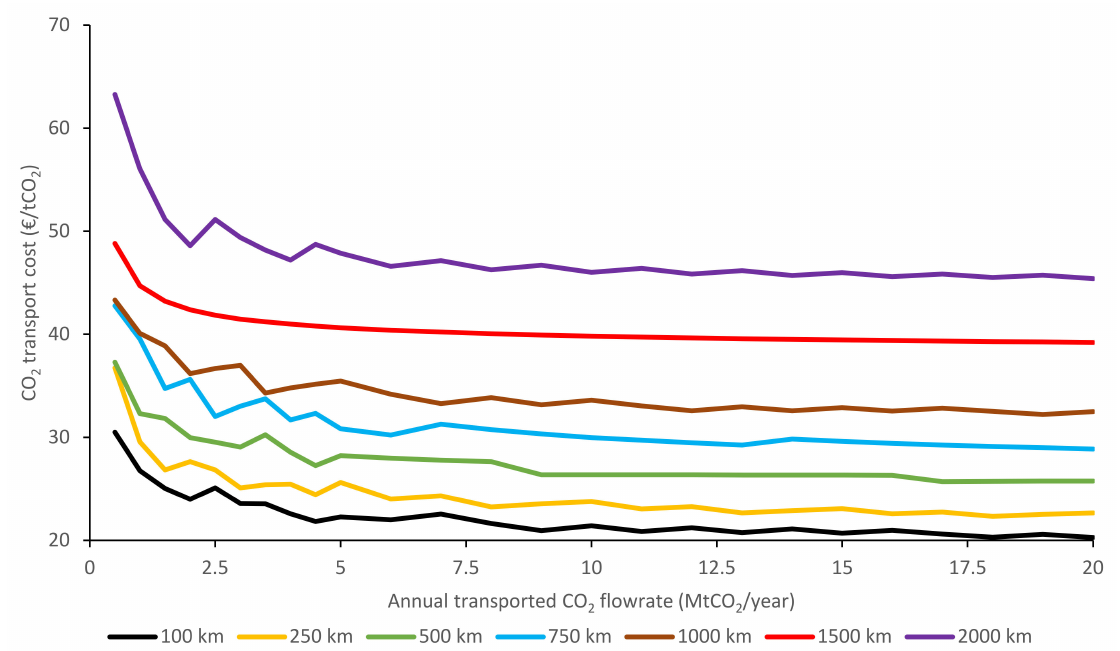
Figure A2. CO 2 conditioning and transport costs as a function of transport distance and annual volume when transporting pure CO 2 between two harbours by ship at 15 barg.